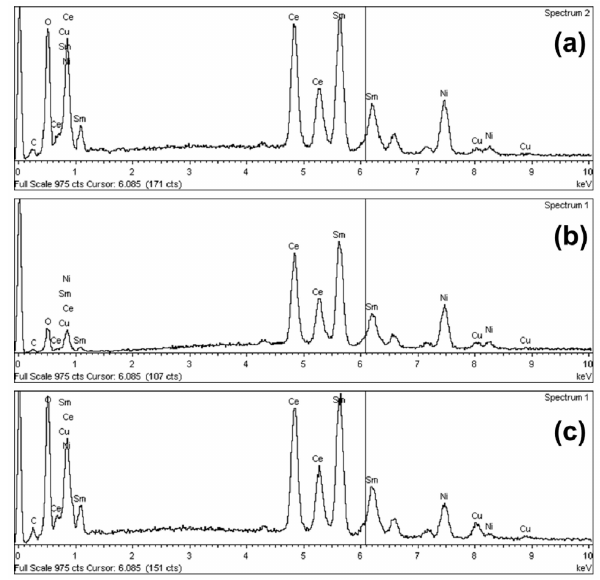
Figure 3. Scanning electron microscopy images of the Ni/Ce-Sm-xCu catalysts: ( a ) 5% Cu; ( b ) 7% Cu; ( c ) 10% Cu.